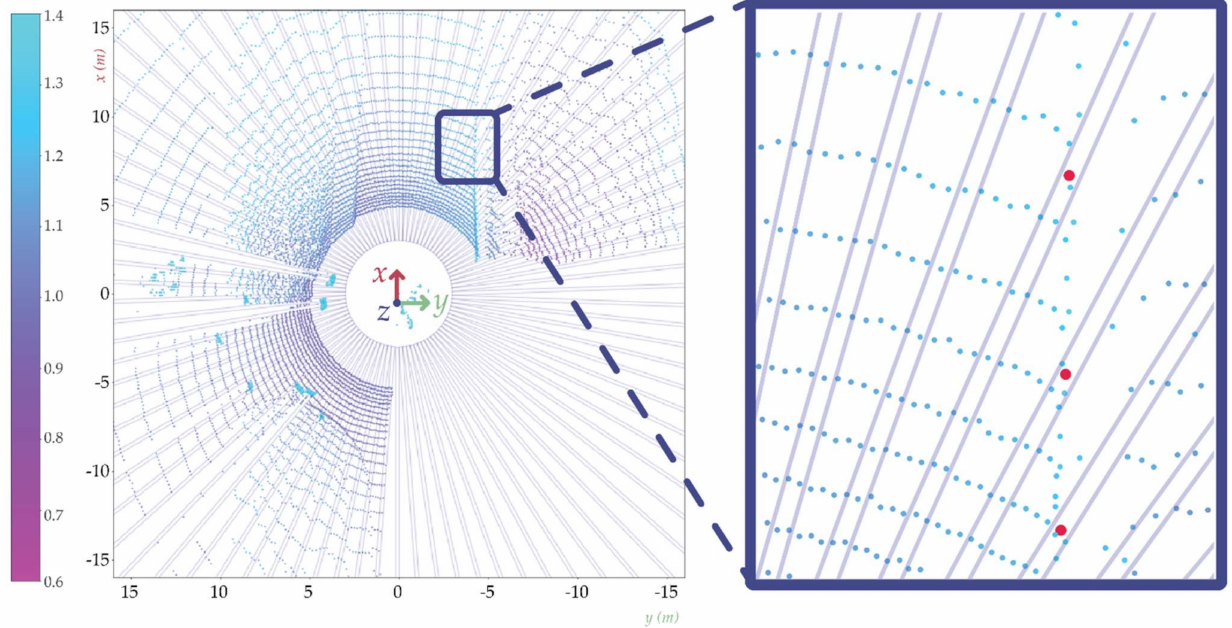
Figure 2. Star-shaped search method, the long rectangles (boxes) in circular layout represent the cut out from the original LIDAR point cloud. On the right in the zoomed image, the red dots are the sidewalk starting